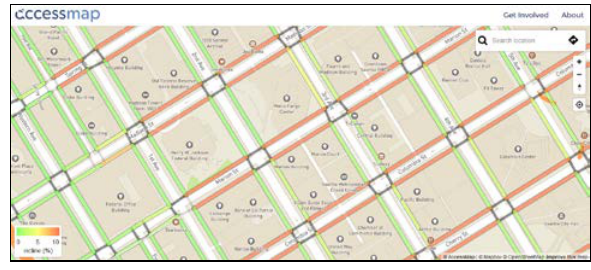
Figure 2. City of Seattle’s accessibility map While the maps showing the inclination of the streets (Figure 2) are generated automatically by analysing topographic information, the more detailed maps (Figure 1 and Figure 3) are generated based on visual inspection and/or